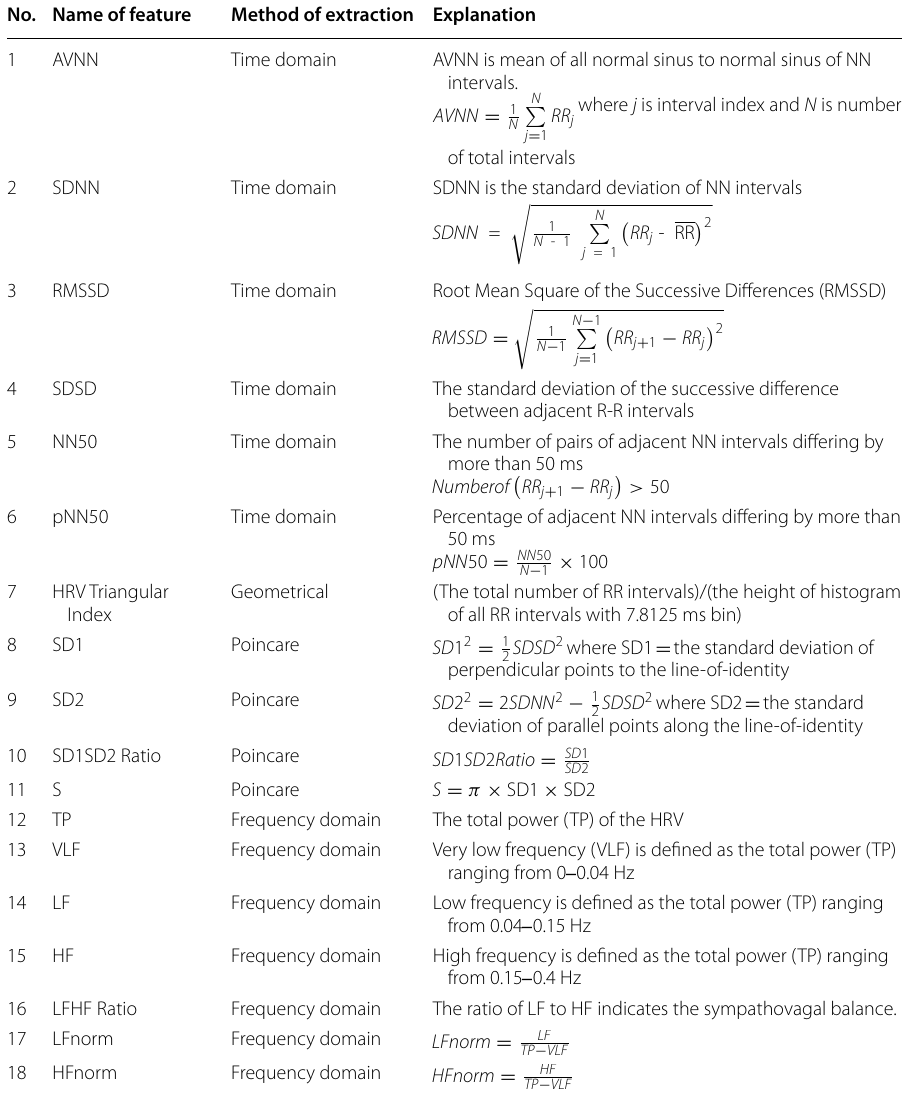
Table 2 The list of features extracted from HRV No. Name of